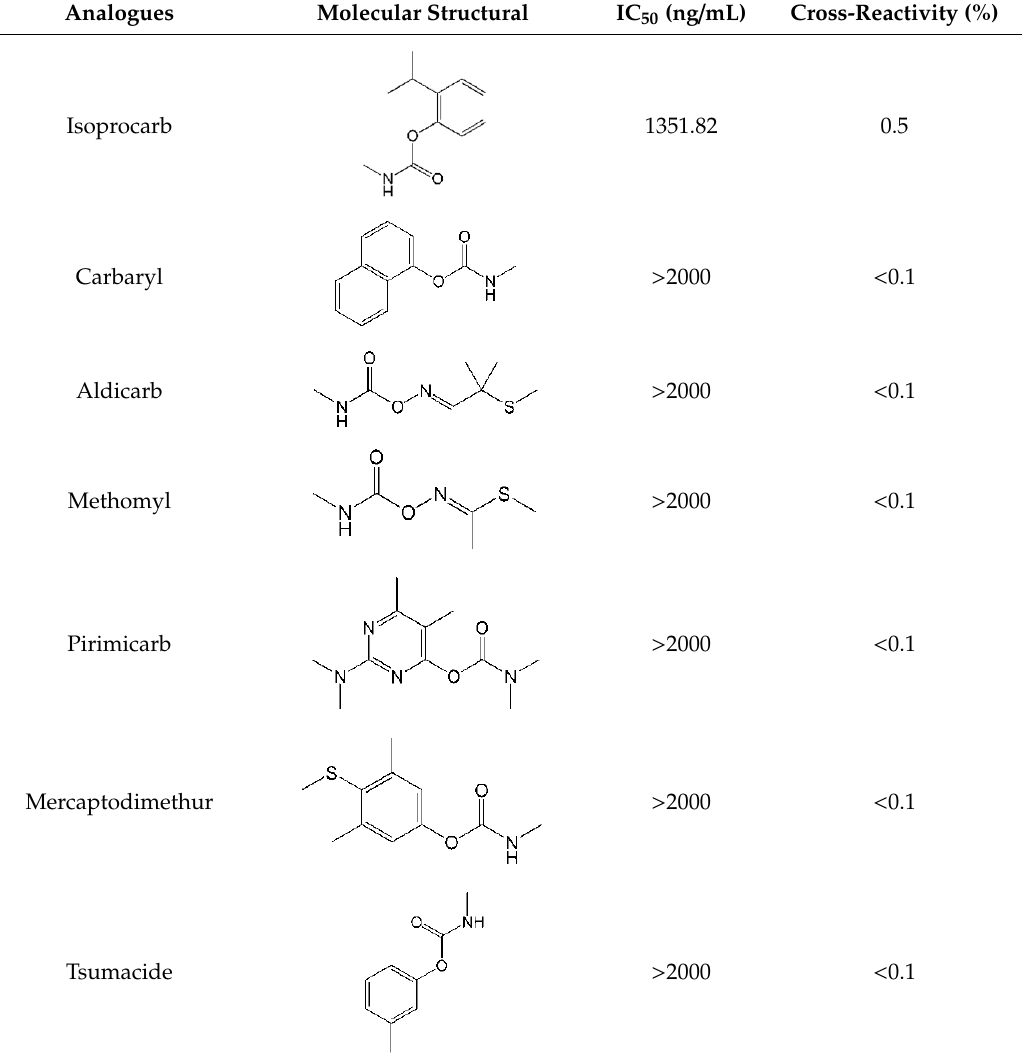
Figure 6. Matrix effects of Chinese cabbage, cucumber, and orange samples. Table 2. Recovery analysis of carbofuran in Chinese cabbage, cucumber, and orange samples by ic-ELISA. Added (mg/kg)